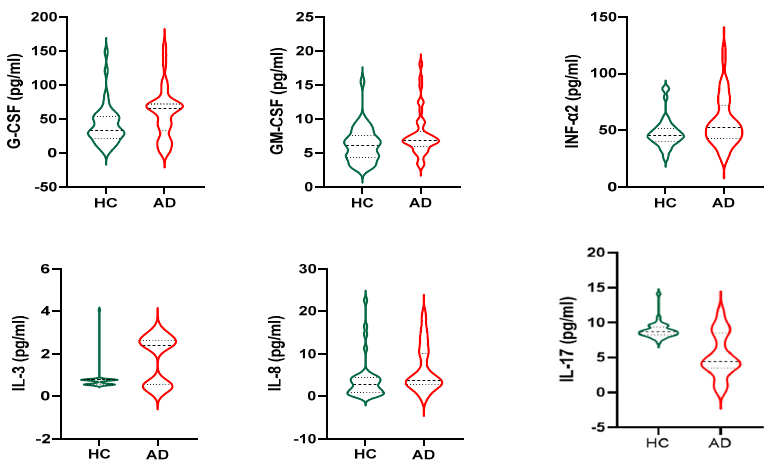
Figure 1. Cytokines that significantly differ between groups. HC: Healthy Control; AD: Alzheimer’s Disease.